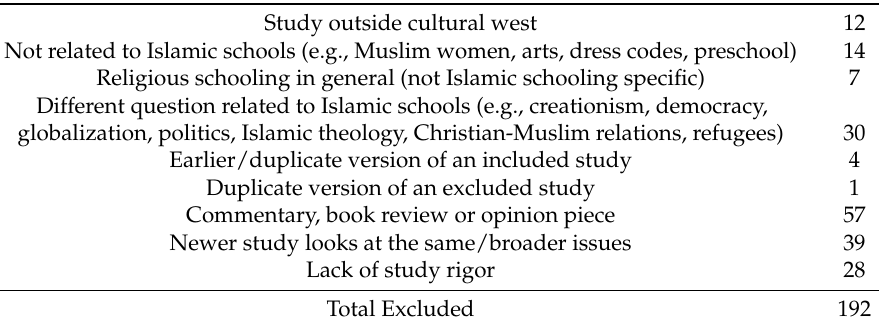
Table 2. Reason for Exclusion—192 sources were excluded at full article